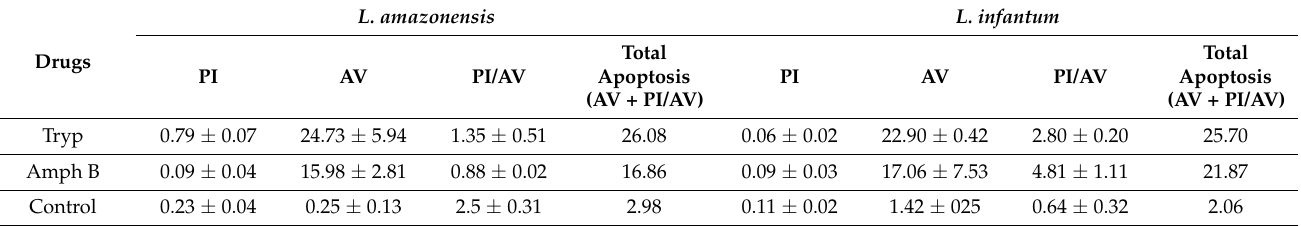
Table 2. Flow cytometry analysis of L. amazonensis and L. infantum promastigotes treated with tryptanthrin. The results are demonstrated as the percentage of propidium iodide (necrosis),